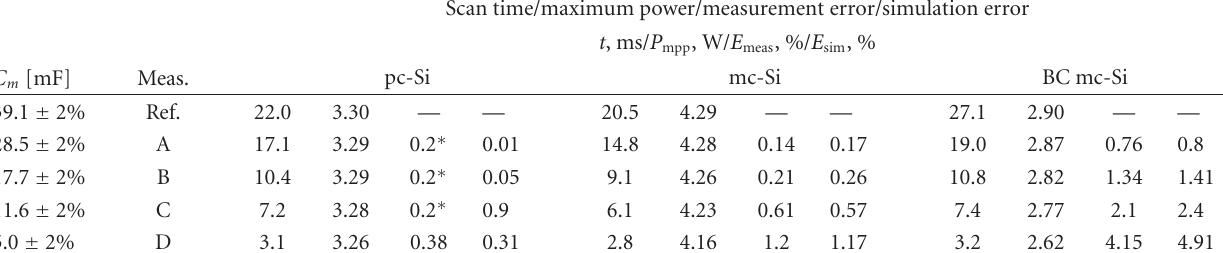
Table 3: Capacitive curve tracer I-V results: measurement versus